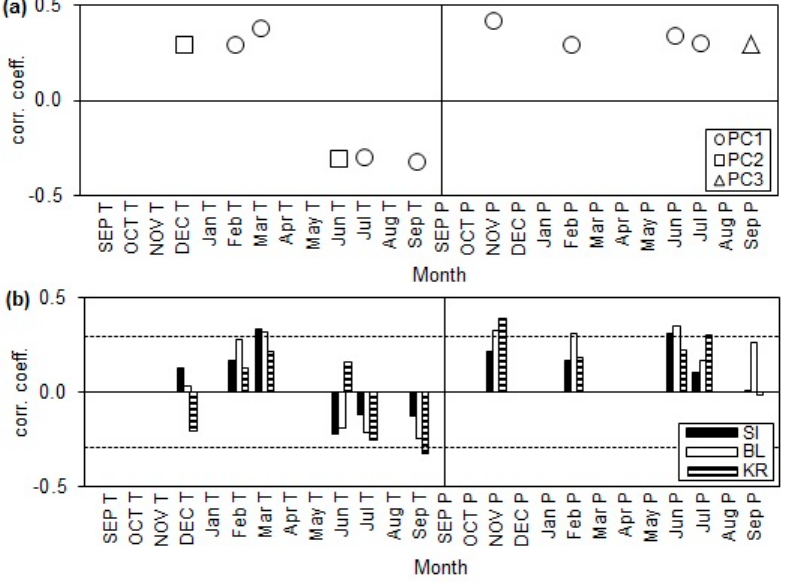
Figure 5. Significant correlation coefficients ( p < 0.05) between the yearly scores of PC1, PC2 and PC3 and the mean monthly air temperatures (T) and total monthly precipitations (P) from the previous September (SEP) to the current September (Sep) for the period of 1971–2015 ( a ). Correlation coefficients between the mean indexed chronologies for the provenance trials in Siemianice (SI), Bli ż yn (BL) and Krynica (KR) and the above-mentioned climatic data. The 95% confidence level—dashed lines ( b ).